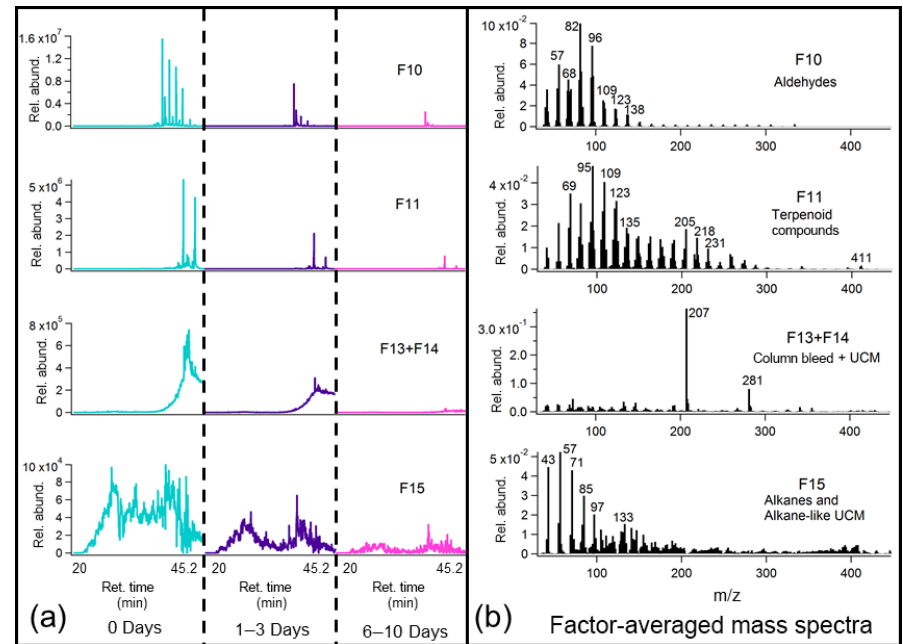
Figure 4. Average binned chromatograms and mass spectra for factors 1–9 + 12 (F1–9 + 12) in PMF 15-factor solution on TAG oak leaf BBOA compound window data. Relevant plots obtained in PMF calculations are provided in the Supplement (Figs. S12a and S13a). These chromatograms were obtained from PMF calculations by averaging binned data corresponding to triplicate chromatograms at each level of oxidation. The triplicate-averaged binned chromatograms at each equivalent aging time are displayed in one trace; different aging times are demarcated with vertical lines across the x axis. Average binned chromatograms and mass spectra for factors 10–15 (F10–15) in PMF 15-factor solution on TAG oak leaf BBOA compound window